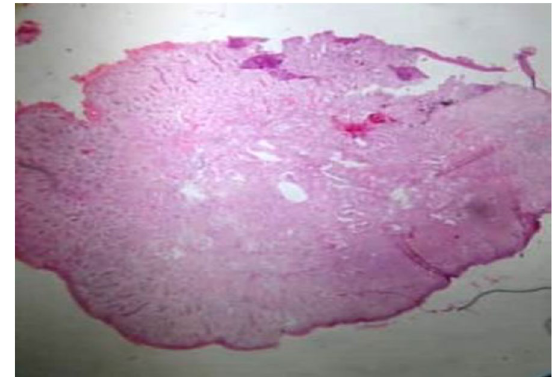
Fig. 2 Light micrograph of the polypoid structure covered by squamous epithelium with reactive epithelial changes and containing granulation tissue formation along with granulomatous inflammation surrounding the hair shafts (H&E stain;